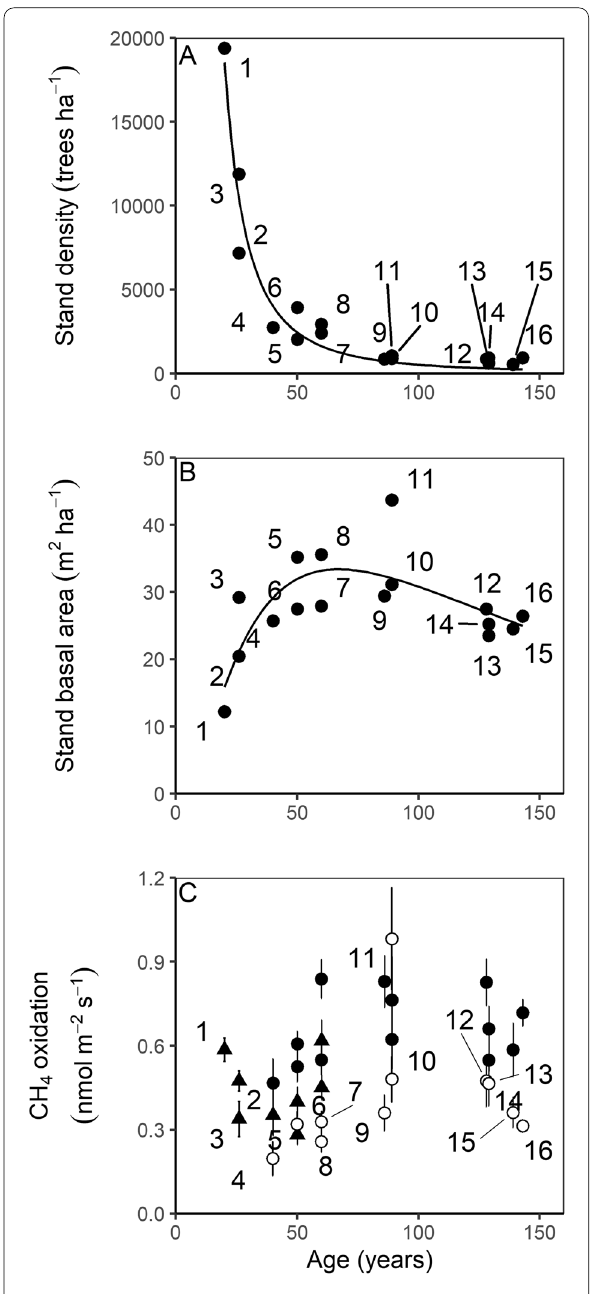
Fig. 1 Relationship between stand age and A stand density, B stand basal area, or C potential CH 4 oxidation in the top soil layer (intact soil cores) in fall 2018 (close circles), spring 2019 (open circles) and summer 2019 (close triangles) in 16 neighbouring stands of sessile oak, aged 20 to 143 years. In panel A and B , the solid lines show the fitted non-linear models: a power function for the relation between stand density and age ( R 2 0.95, p < 0.001), and a three-parameter = lognormal function for the relation between stand basal area and age ( R 2 0.56, p < 0.001). There was no significant trend between CH 4 = oxidation and age, regardless of season. Numbers are the ID of the stands, from youngest to oldest (shown only once in C , in summer 2019 for the three additional youngest stands added late and in